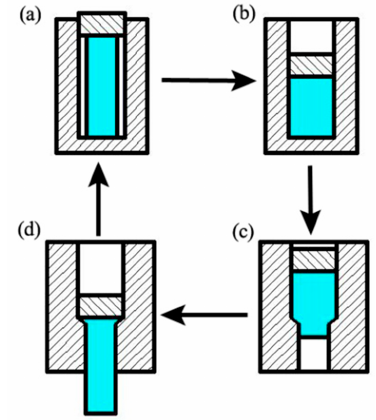
Figure 1. Schematic diagrams of repetitive upsetting extrusion (RUE): ( a ) the upsetting process; ( b ) the end of the upsetting process; ( c ) the extrusion process; and ( d ) the end of the extrusion process.